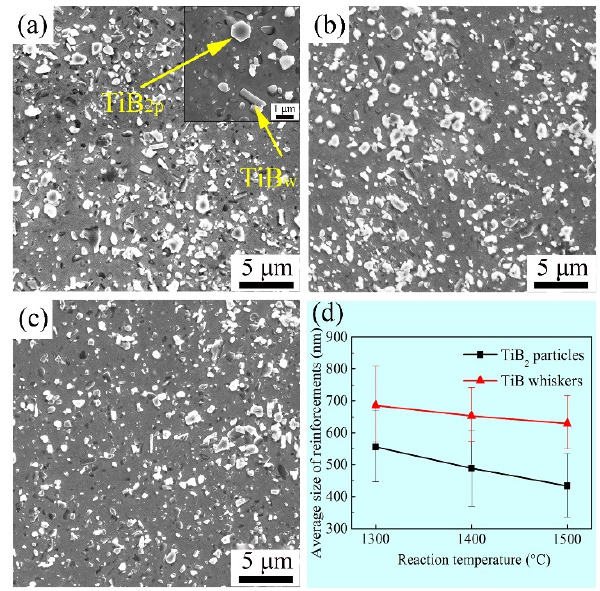
Figure 2. The microstructures and average size of reinforcements in as-cast (TiB 2p +TiB w )/Cu compo- sites at different reaction temperatures. ( a ) 1300 °C, ( b ) 1400 °C, ( c ) 1500 °C, ( d ) the average size of reinforcements versus reaction temperature.